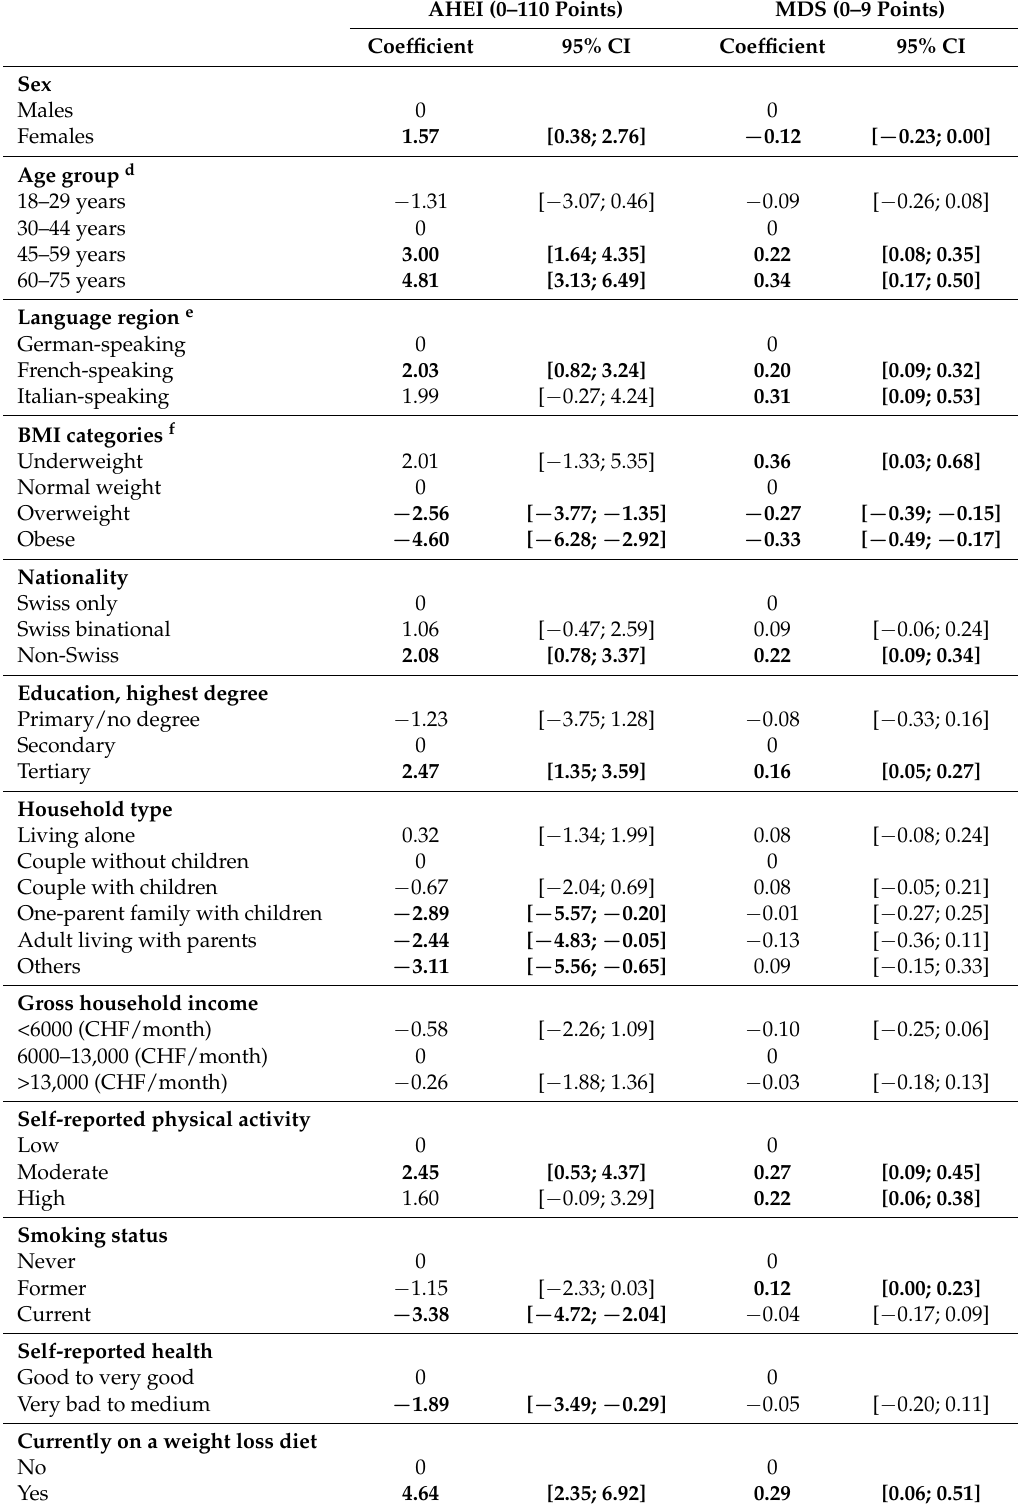
Table 2. Association between diet quality scores and sociodemographic and lifestyle factors ( n = 2057) a,b,c . AHEI (0–110